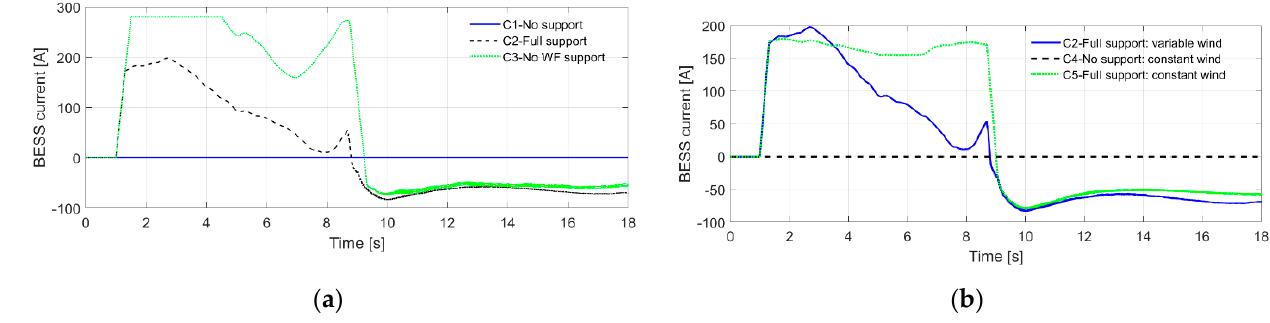
Figure 10. BESS cell current: ( a ) Variable wind speed; ( b ) Constant wind speed compared to Case 2.